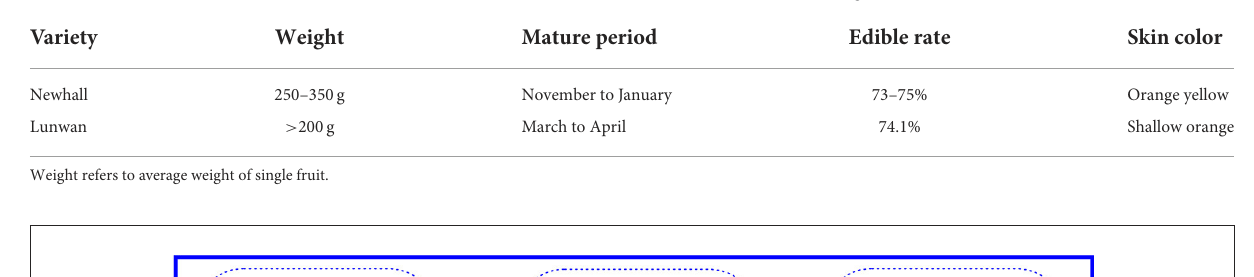
TABLE 2 The differences and similarities between two varieties derived from www.baidu.com with keywords of Newhall and Lunwan in Chinese.